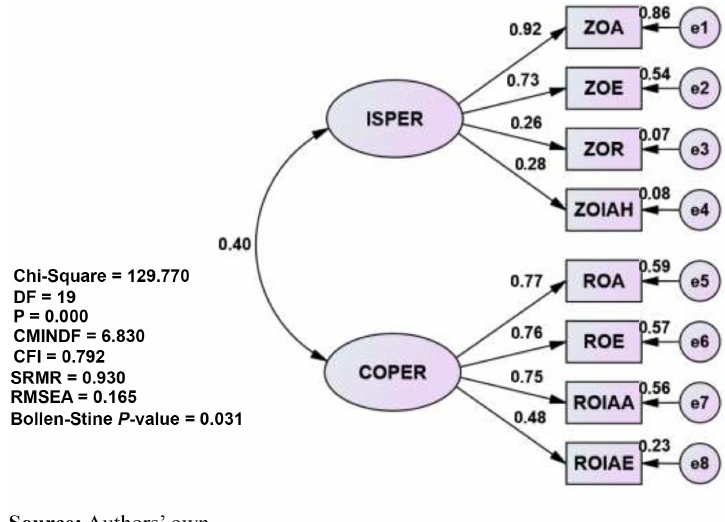
Figure 4. CFA model of multi- bank performance (ISPER